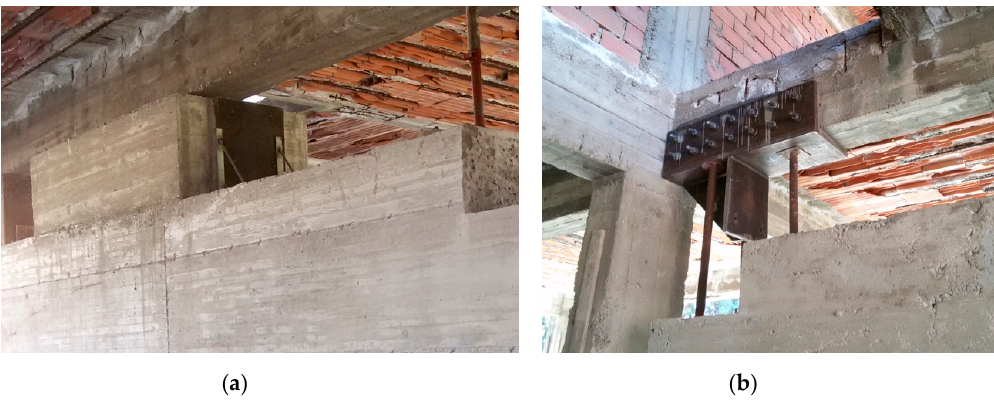
Figure 7. Reaction walls: Steel reinforcement ( a ) and fully casted wall ( b ).